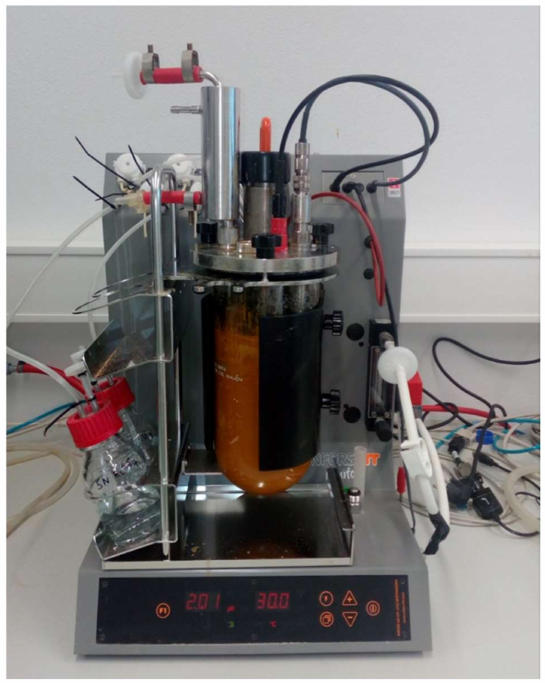
Figure 2. Bacterial leaching of sludge sediment in the Minifors 2.5 LTV bioreactor with automatic pH and temperature control